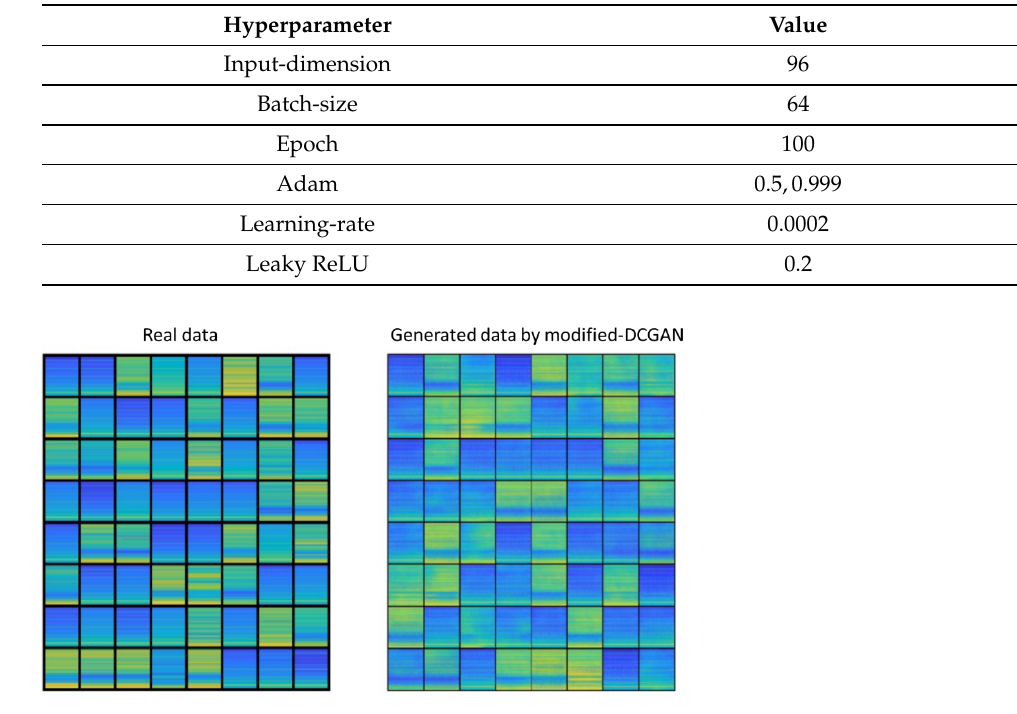
Figure 8. Generated data through proposed modified DCGAN.